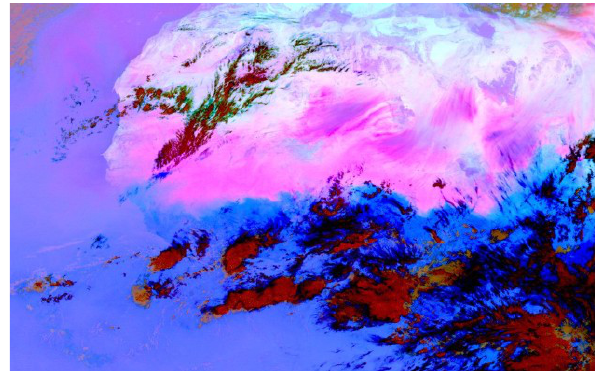
Fig. 11. MSG-SEVIRI satellite image over West Africa for 8 March 2006 at 12:00 UTC. Pink color represents dust, black: cirrus, red: high-level cloud, brown: mid-level cloud, and white: desert surface.